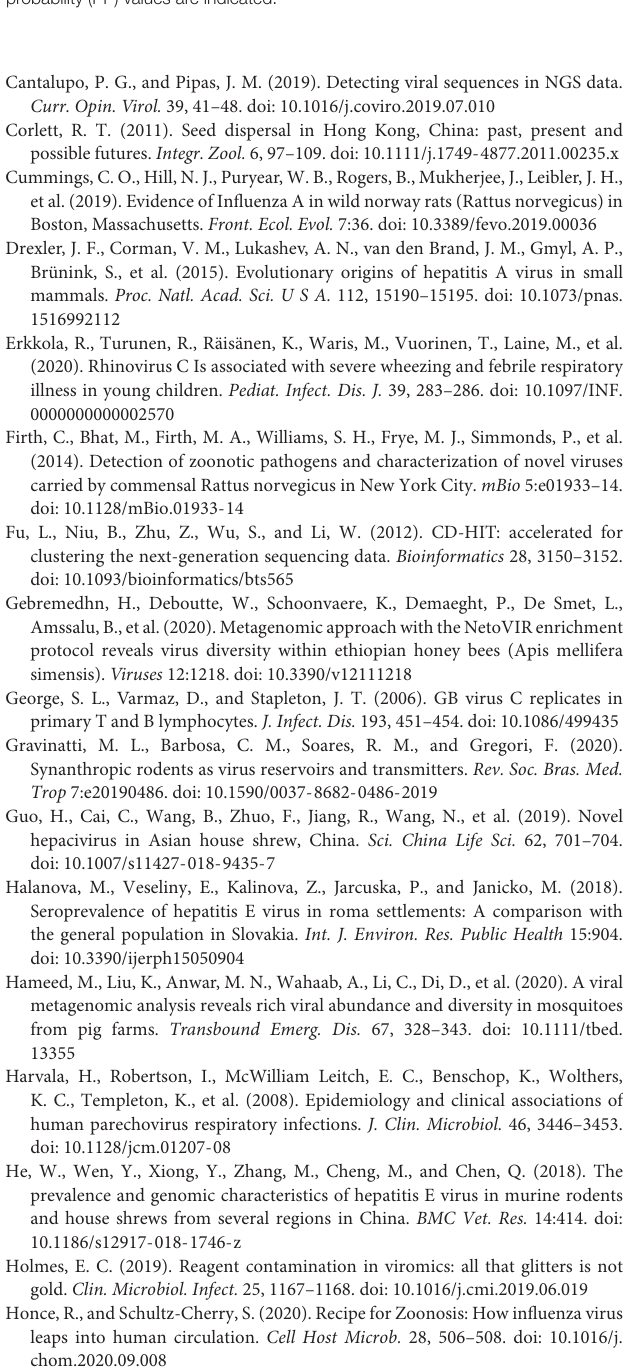
Supplementary Figure 5 | Relative abundance of the sequences related to mammalian viruses (genus level) in the serum and liver samples from R. norvegicus . Sequences with relative abundance less than 1% are not showed. Supplementary Figure 6 | Phylogenetic tree constructed based on potential viral nucleotide sequence (100 bp, polyprotein gene) related to hepacivirus that obtained by using metagenomic sequencing (MrBayes, GTR + G + I nucleotide substitution model). A total of 29 representative sequences belonging to different species within genus Hepacivirus are included for comparison. One sequence belonging to genus Flavivirus is set as outgroup. Percentages of the posterior probability (PP) values are indicated.